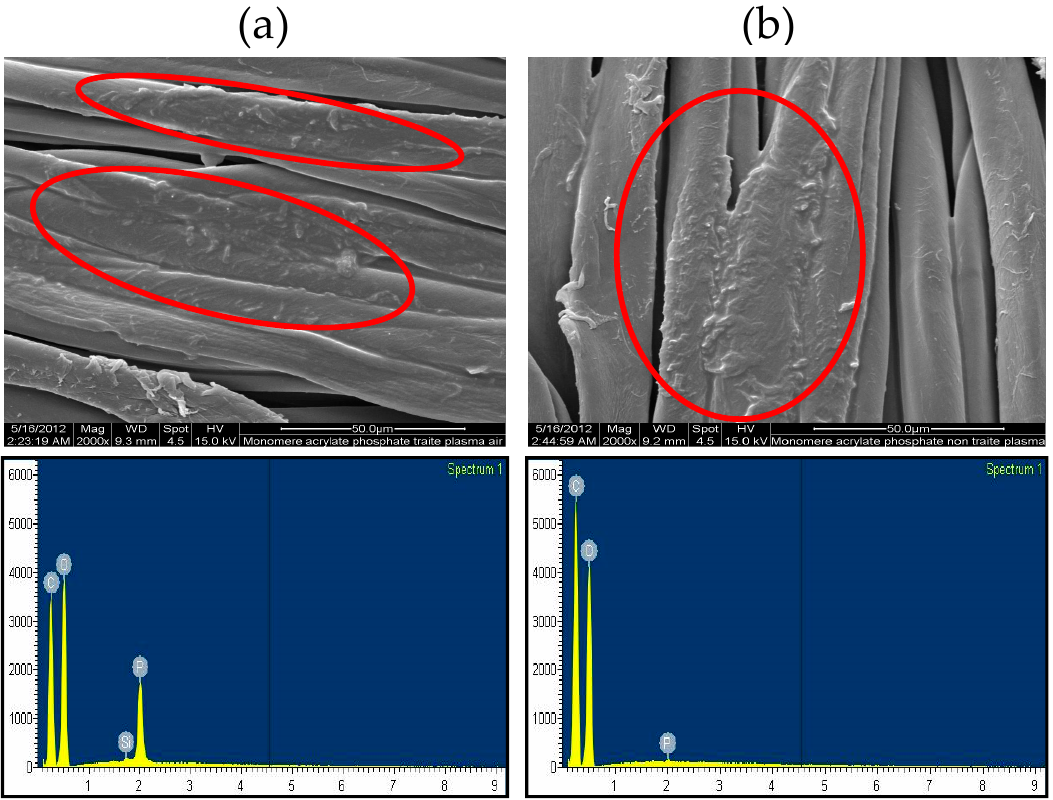
Figure 3. Scanning electron microscopy (SEM) and energy dispersive x-ray (EDX) images of flame-retardant cellulosic fibers: ( a ) before washing and ( b ) after washing.